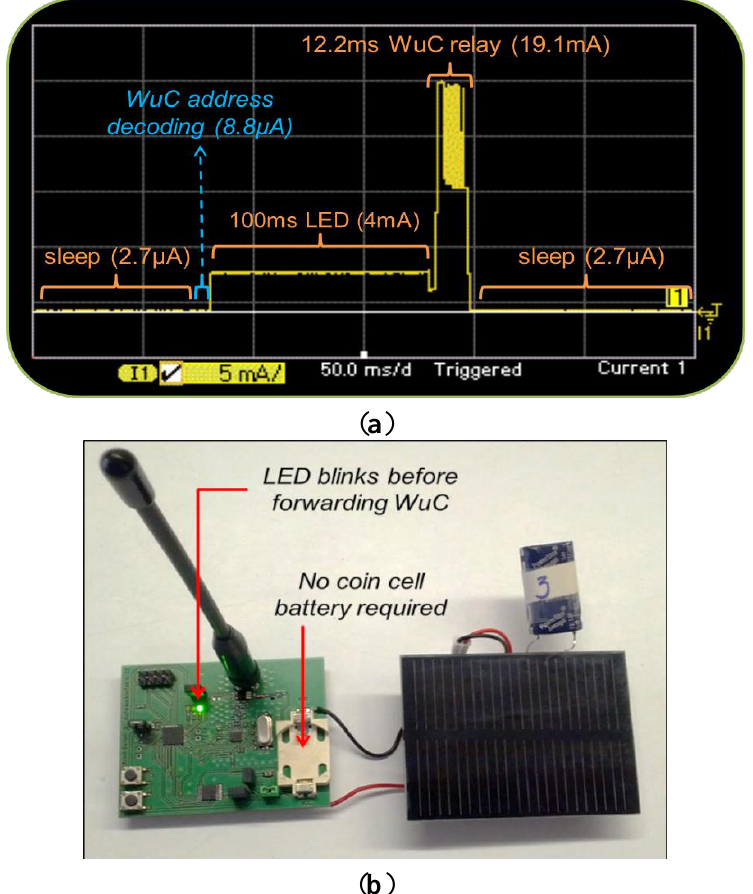
Figure 8. ( a ) Power analyzer trace of a SCM-WuR relay node; ( b ) Powering the relay SCM-WuR node by means of a solar cell and a